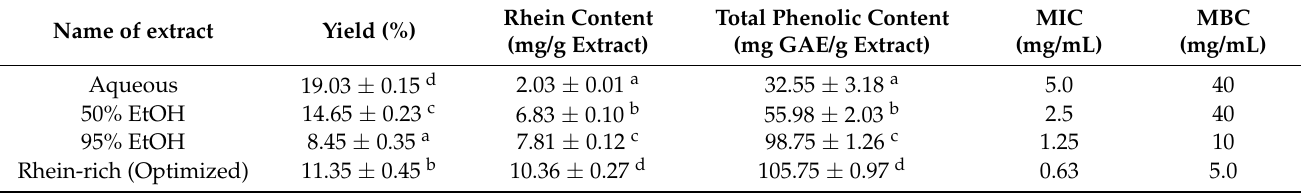
Table 9. Yields, rhein contents, total phenolic contents, MIC and MBC against S. aureus in S. alata leaf